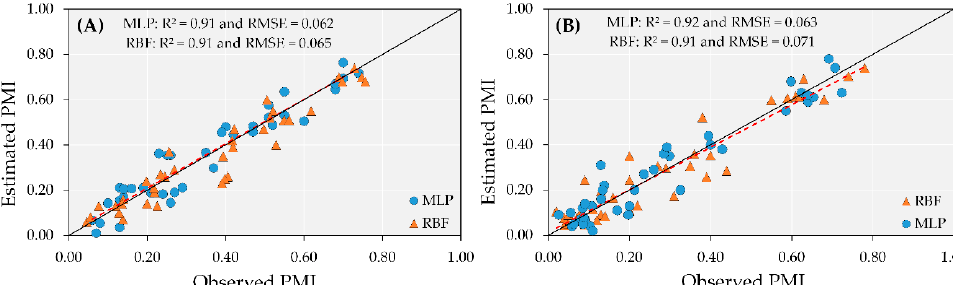
Figure 6. Test performance of artificial neural network (ANN) models (MLP and RBF) to predict peanut maturity index (PMI) in irrigated ( A ) and rainfed ( B ) areas.